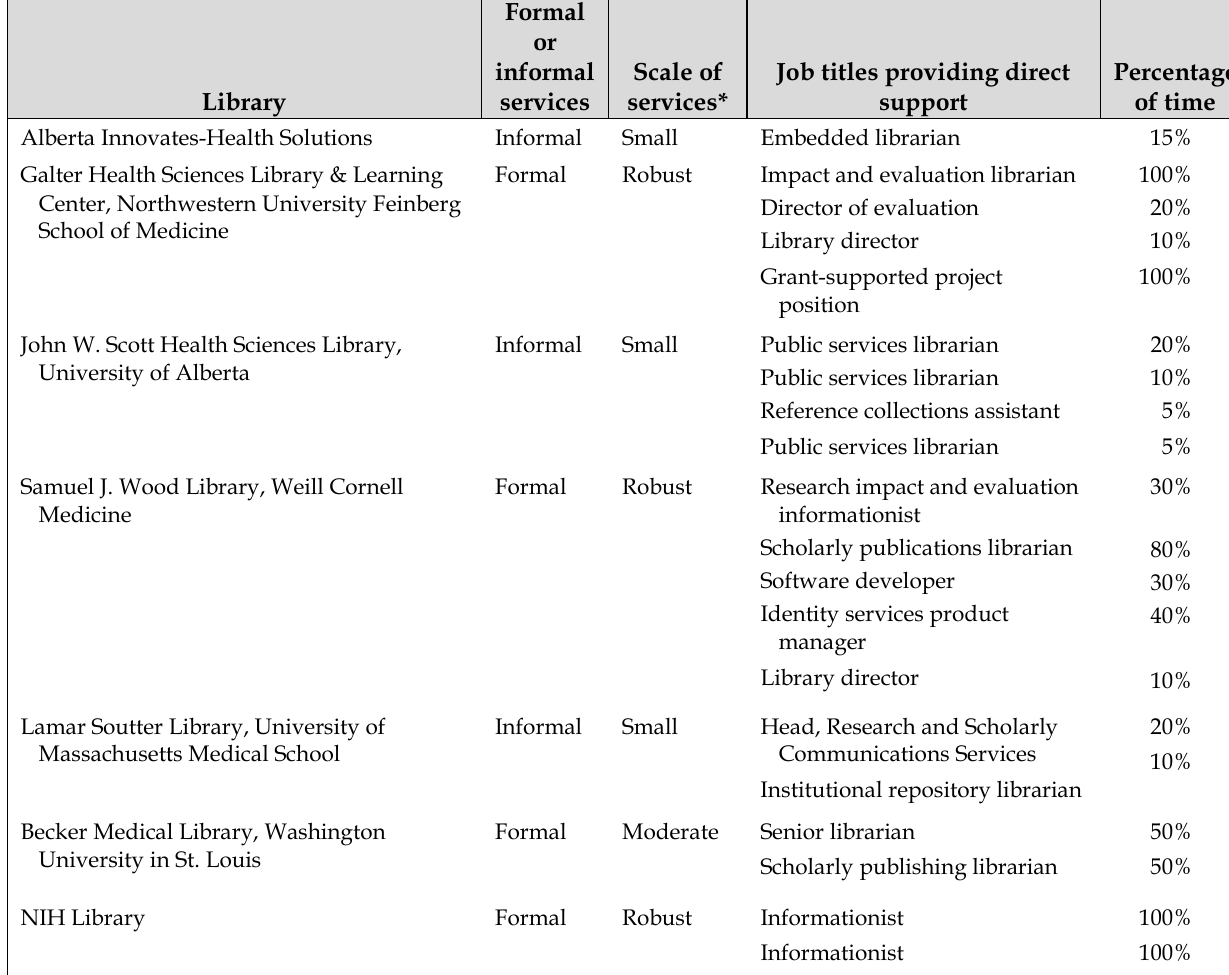
Table 2 Type and scale of services, including job titles and percentage of